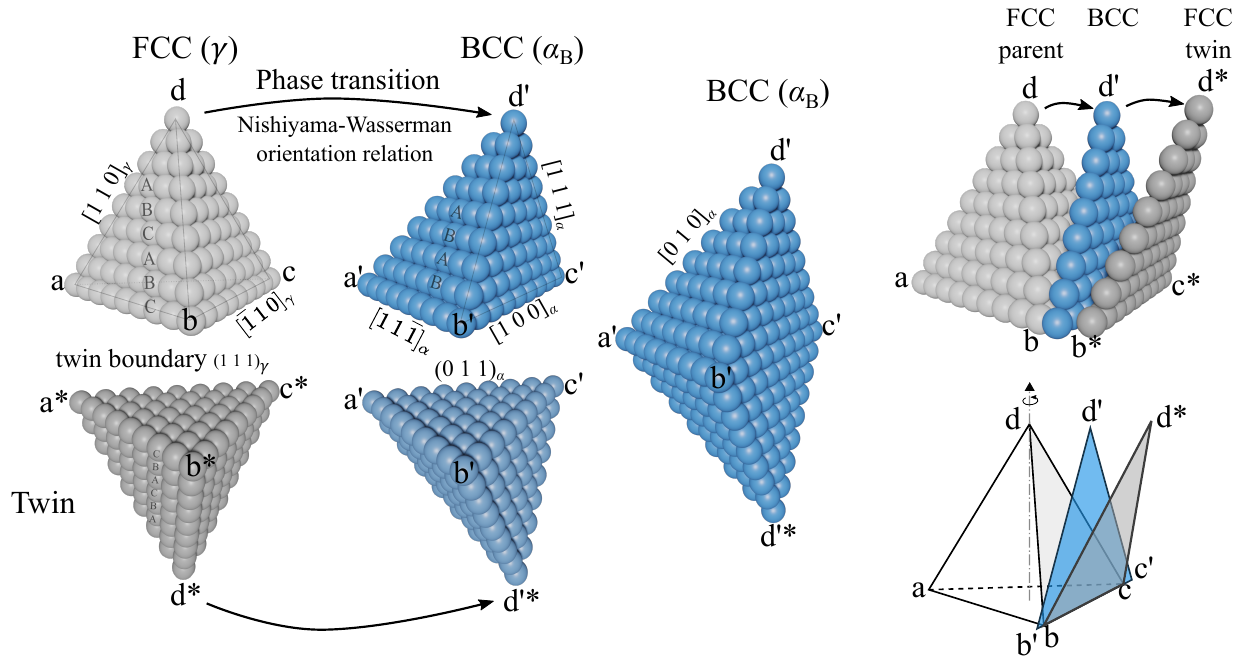
Figure 10. Double Thompson’s tetrahedrons showing the change of atom lattice structure during bainitic/martensitic transformations; The FCC → BCC transformation is represented by the grey and blue tetrahedrons without loss of generality. In this configuration two twin-related FCC lattice tetrahedrons transform into the same BCC lattice if their habit plane ( 111 ) γ (cid:107) ( 011 ) α is coplanar to the twin boundary. Atom correspondence (displacive strain) is illustrated on the highlighted close-packed plane bcd , on which the phase transition moves the top atom from point d to d (cid:48) , while twinning moves it to point d ∗ . All lattices are drawn with parameters of iron at 420°C and the Nishiyama-Wassermann orientation